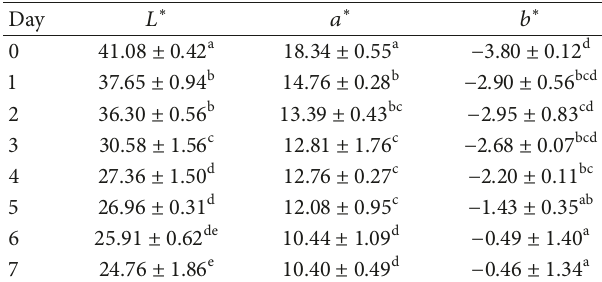
Table1: 𝐿 ∗ , 𝑎 ∗ ,and 𝑏 ∗ valuesofgillsfrom Euthynnusaffinis storedat 4 ∘ C for 7 days. Values are means ± SD ( n = 3). Different superscript letters indicate significant differences ( 𝑝 < 0.05